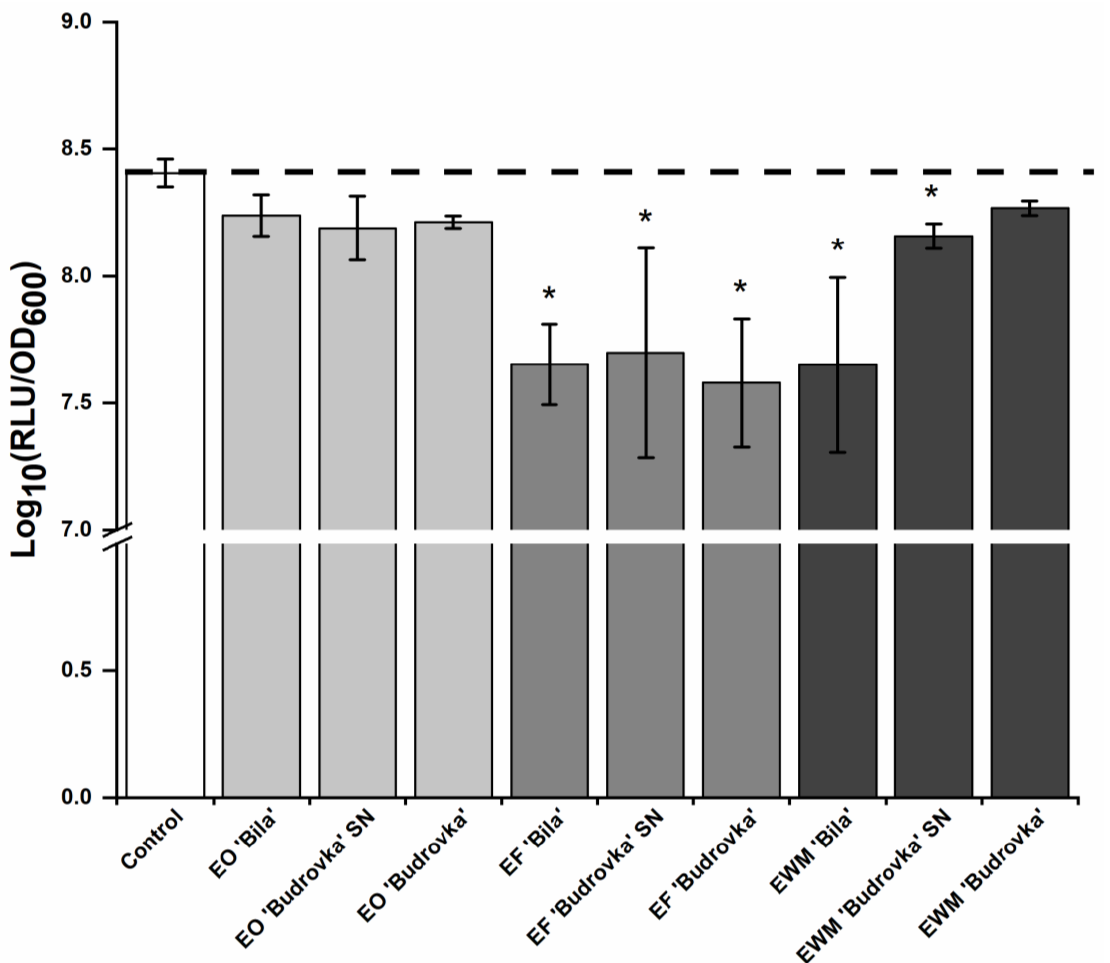
Figure 1. Effect of different lavandin formulations (EOs, EFs and EWMs) at subinhibitory concen- tration (0.25 × MIC) on the intercellular signaling of C. jejuni NCTC 11168. C. jejuni NCTC 11168 was cultivated for 24 h without or with the addition of lavandin formulations at subinhibitory concen- tration. Afterwards, SMs were prepared and added to V. harveyi MM30 biosensor strain. V. harveyi MM30 bioluminescence response was the indirect measure for C. jejuni intercellular signaling. Log 10 average values ± SD are shown. * p < 0.05, vs. control. (EO, essential oil; EF, ethanolic extract prior to distillation; EWM, ethanolic extract of post-distillation waste material).